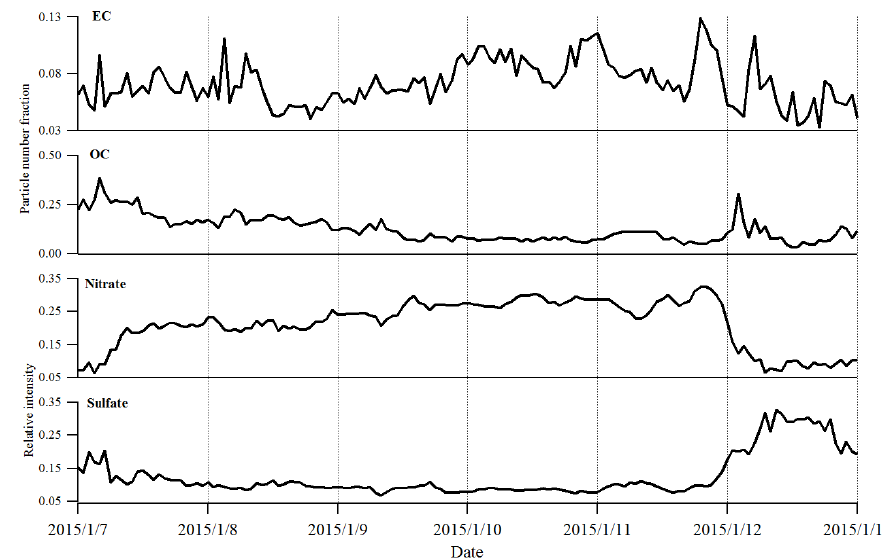
Figure 7. Temporal evolutions of chemical compositions determined by SPAMS during the representative PM episode.